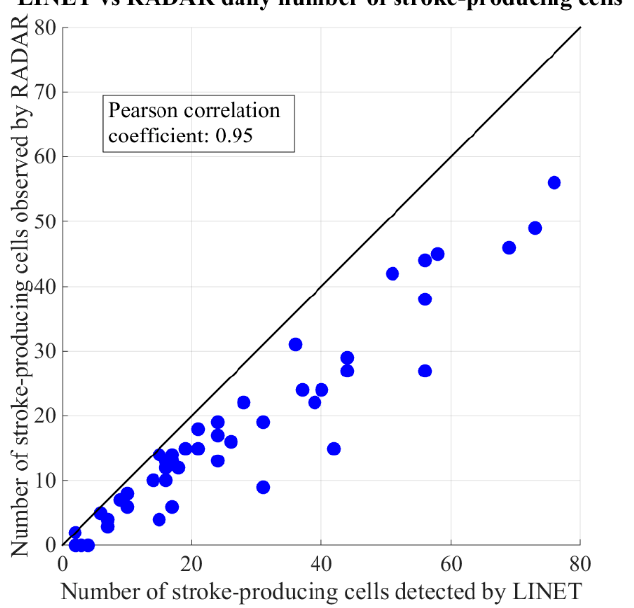
Figure 7. Comparison between the number of rain cells producing strokes observed by LINET ( x -axis) and detected by QDA-based multi-parameter algorithm ( y -axis) for each thunderstorm day. Pearson correlation coefficient is overimposed to the scatter plot.